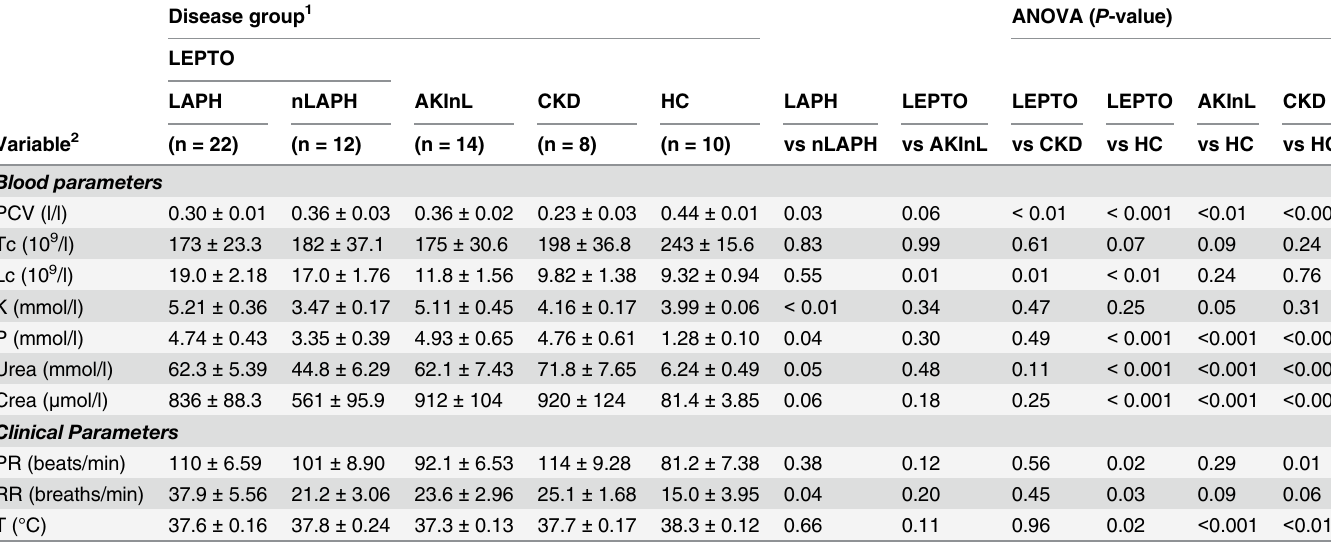
Table 2. Mean ± SEM of clinical characteristics of all dogs on the day of or one day after admission to the clinic. Disease group 1